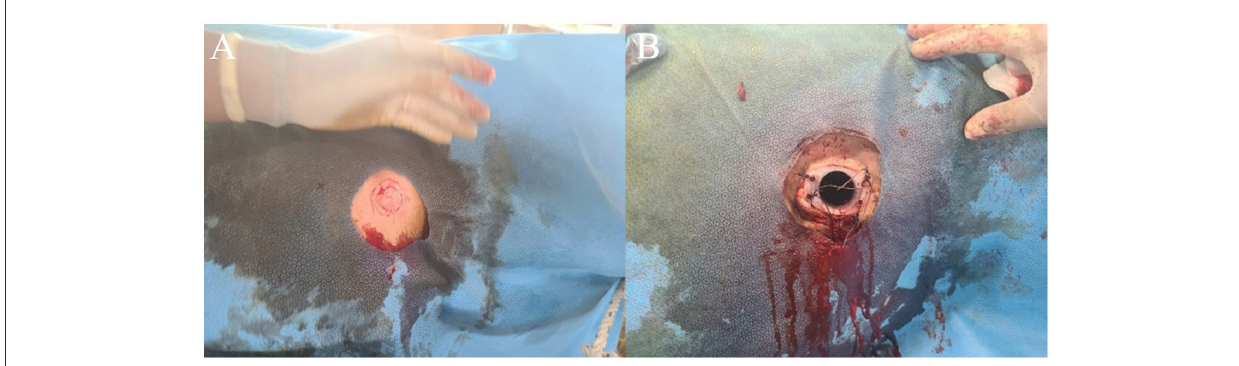
FIGURE2 Temporary rumenostomy in a patient with tetanus (A) . On the third day of the onset of tetanus, a temporary rumenostomy was performed for the treatment of secondary bloat (B) .